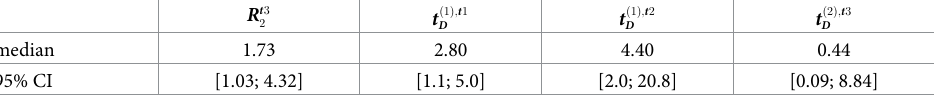
Table 2. Table of computed posterior distributions of parameters of the model. Median values and 95% confidence interval of posterior distributions of parameters computed from the inferred posterior